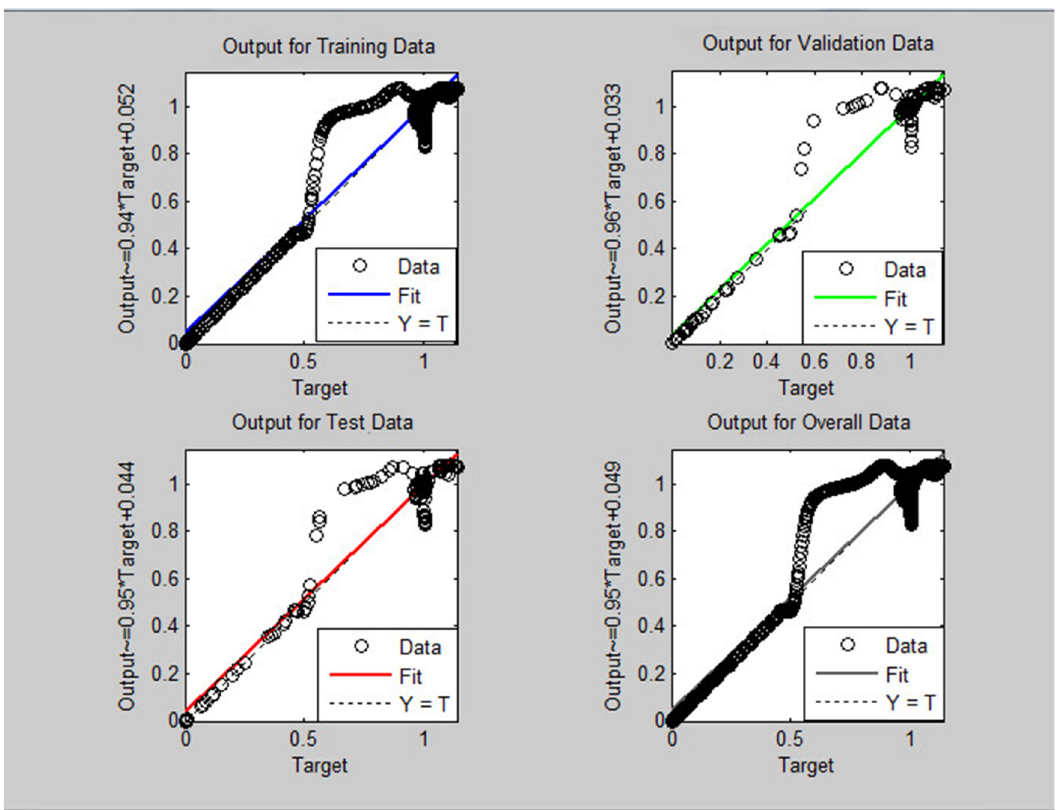
Figure 7. Neural network regression graph for the pitch system.